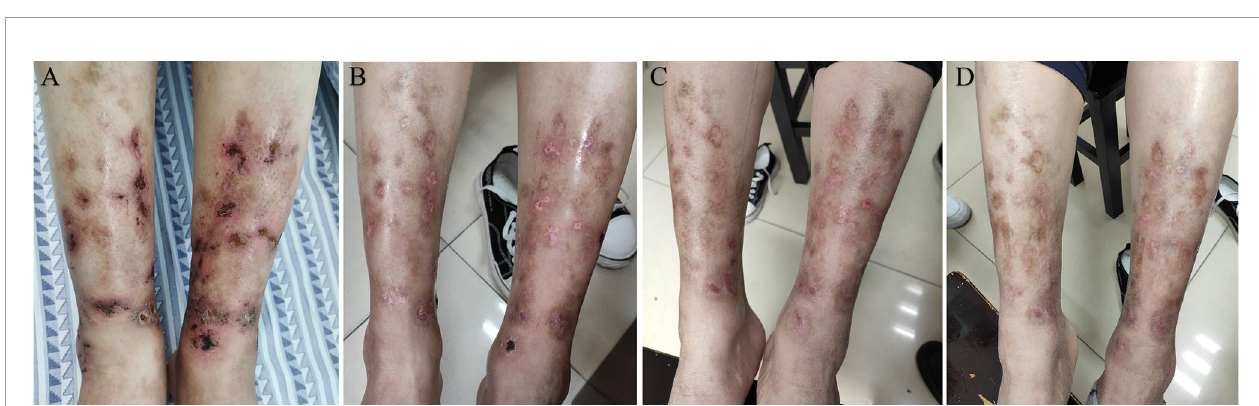
FIGURE 2 | The lower limbs of the patient before and after treatment with tofacitinib. (A) The patient ’ s lower limbs on the initial visit with 2 – 5 mm visible erythema with some ulceration. (B) The lower limbs of the patient after 1 month of tofacitinib administration show an improvement of skin ulcers. (C) The patient ’ s lower limbs after 2 months of tofacitinib treatment reveal complete remission of skin ulcers. (D) The patient ’ s lower limbs did not develop skin ulcers after 6 months of tofacitinib